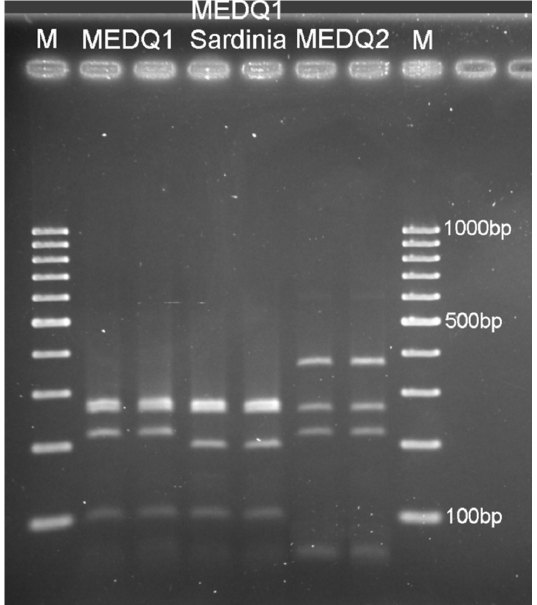
Figure 3. PCR-RFLP profile after digestion with ApoI endonuclease of the COI-PCR product for the following MED haplotypes of Bemisia tabaci : MEDQ1 (expected fragment sizes: ~44, 92, 212, 252, 266 bp, corresponding to the cutting sites at the positions 252, 296, 562 and 654), Sardinian MEDQ1 (~18 not visible, 44, 92, 194, 252, 266 bp, corresponding to the cutting sites at the positions 252, 296, 562, 654 and 672) and MEDQ2 (~44, 212, 252, 358 bp, corresponding to the cutting sites at the positions 252, 296 and 654); M: molecular weight marker (100 bp